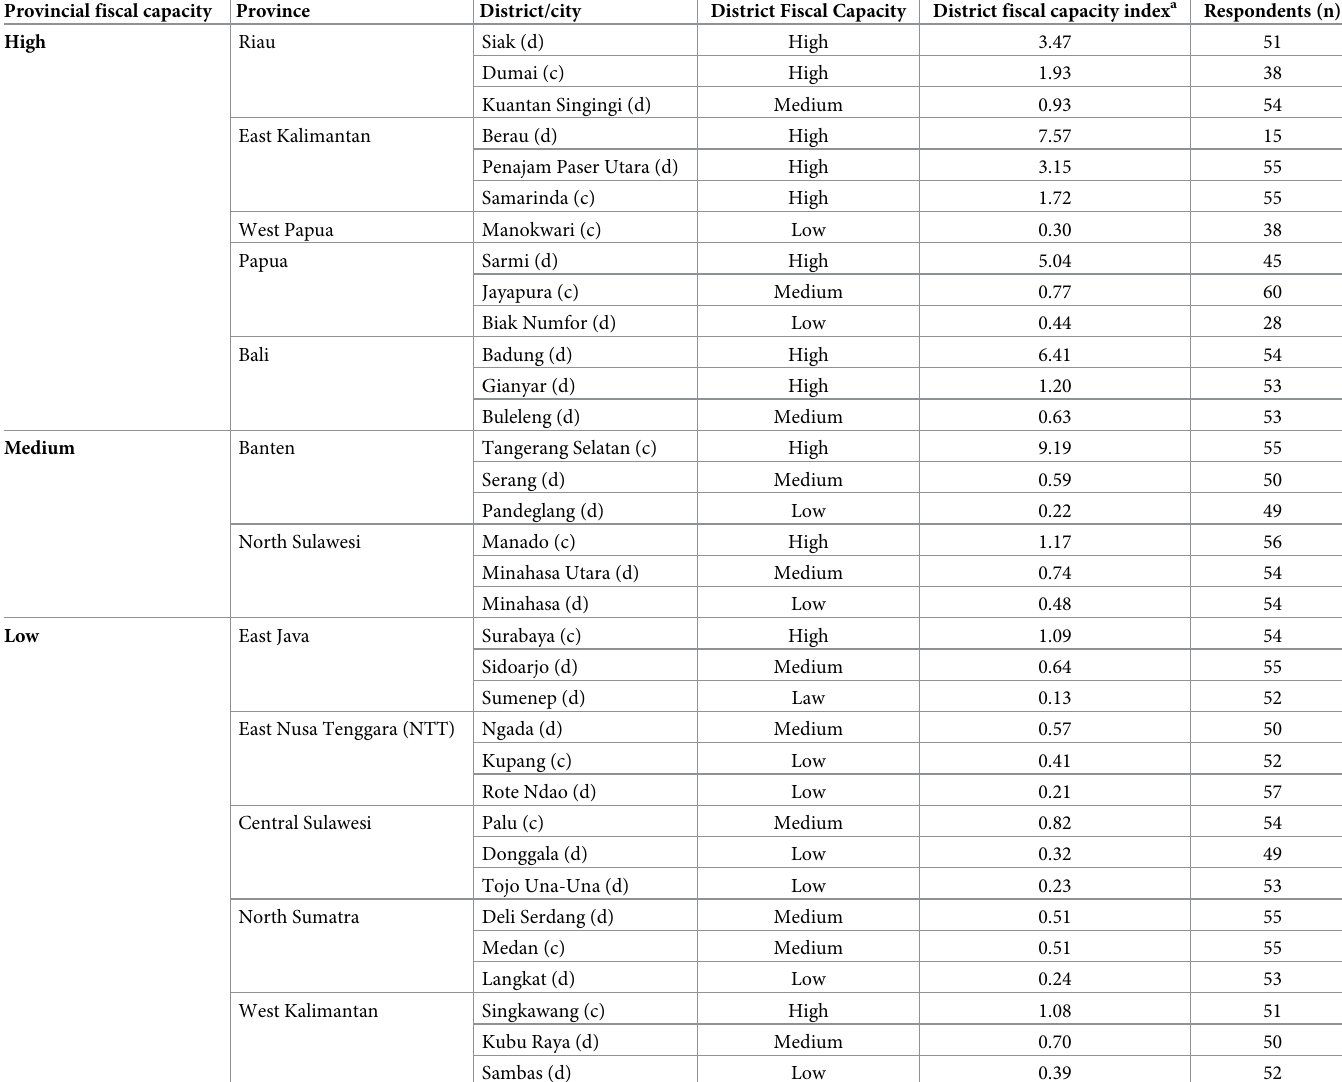
Table 1. Number of respondents per district and province, with each districts’ fiscal capacity